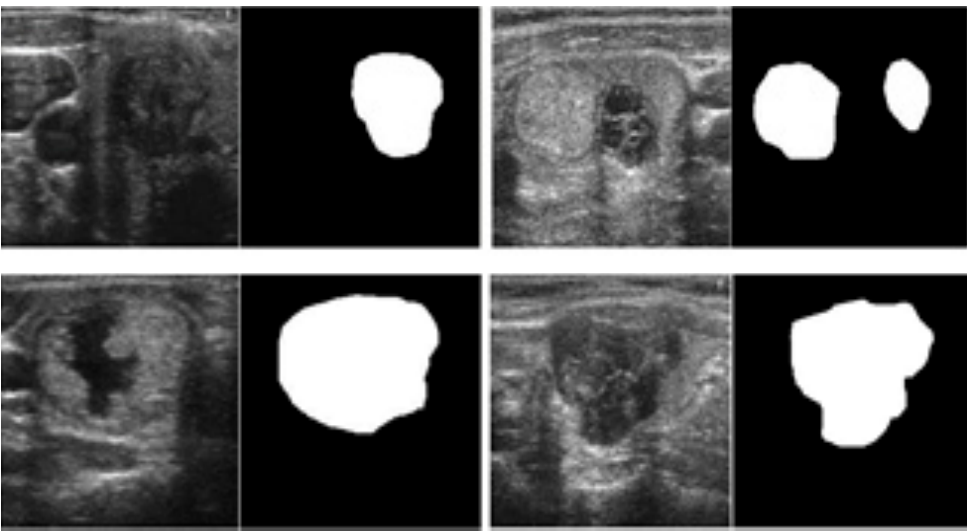
Figure 6. Examples of thyroid images with corresponding ground-truth thyroid region in TDID dataset. Table 3. Detailed descriptions of the 3DThyroid